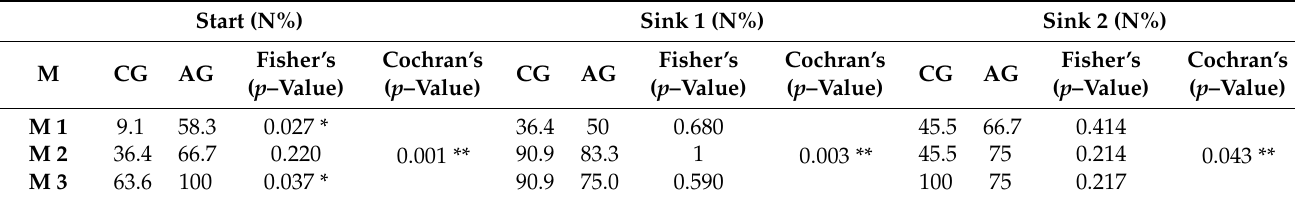
Table 4. Percentage of successful tries within groups in the three